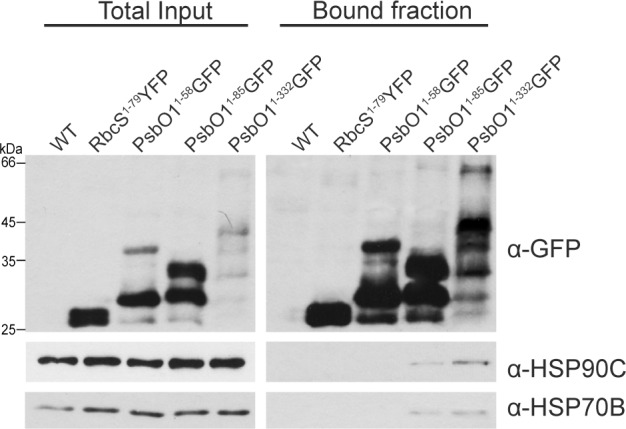
HSP90C interacts and impacts the stroma retention of PsbO1GFP.PsbO11-85GFP and PsbO1GFP were purified with GFP-TRAP beads. Wild-type Col-0 plants (WT), plants expressing RbcS1-79YFP and PsbO11-58GFP were used as controls. Both total plant lysate (total input) and bound fractions were analyzed by immunoblotting using anti-GFP, anti-HSP90C and anti-HSP90B antibodies.